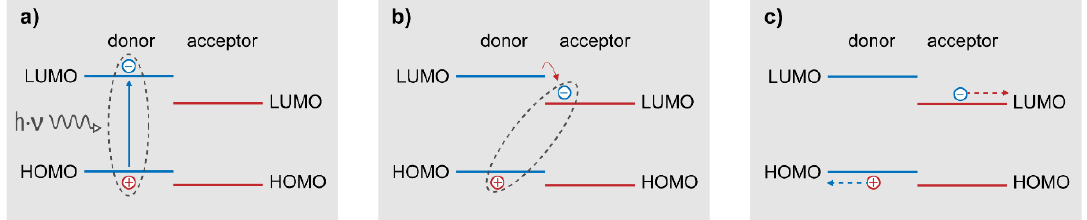
Figure 2. Description of the fundamental processes in OPV devices: ( a ) local exciton generation in the donor, ( b ) charge transfer state formation, and ( c ) free carrier formation and charge collection.